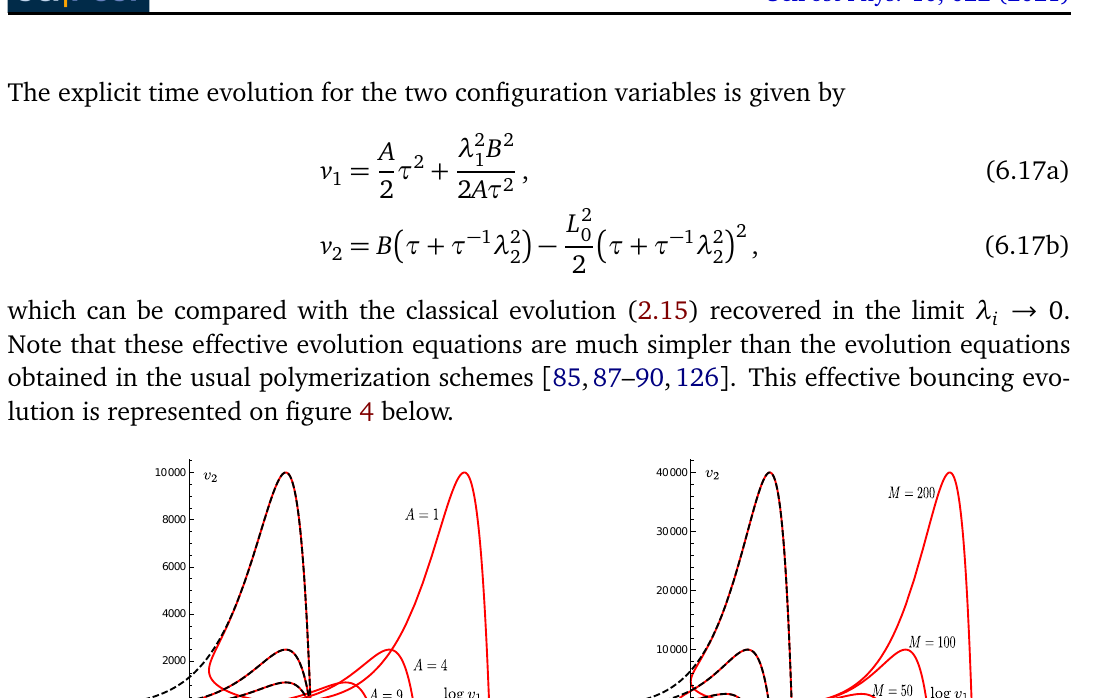
Figure 4: Plot of the effective trajectories in configuration space ( log v compared to the respective classical ones in dashed. On the left, the value of the BH mass (cid:112) A ) is fixed to M = 100 and A = 1, 4, 9. On the right, the mass is varied as M = 50, (i.e. B 100, 200, and A = 1. We take both λ